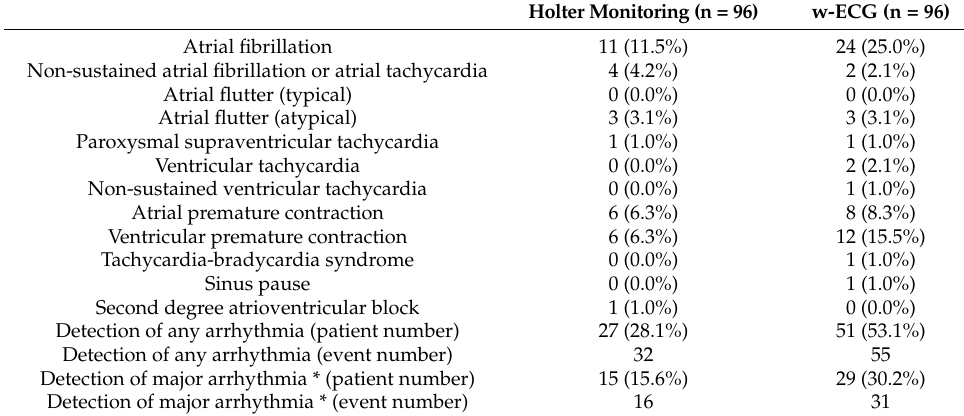
Figure 3. Atrial fibrillation and ventricular tachycardia detected by the w-ECG. Patients #7, #17, and #79 were diagnosed with atrial fibrillation based on w-ECG recordings. The w-ECG was able to record rate-dependent functional QRS widening in patient #79 (blue arrows). Patient #21 was diagnosed with ventricular tachycardia and the initiation point was clearly captured (red arrow). w-ECG: watch-type ECG device. Table 2. Detection of various arrhythmias by Holter monitoring and the